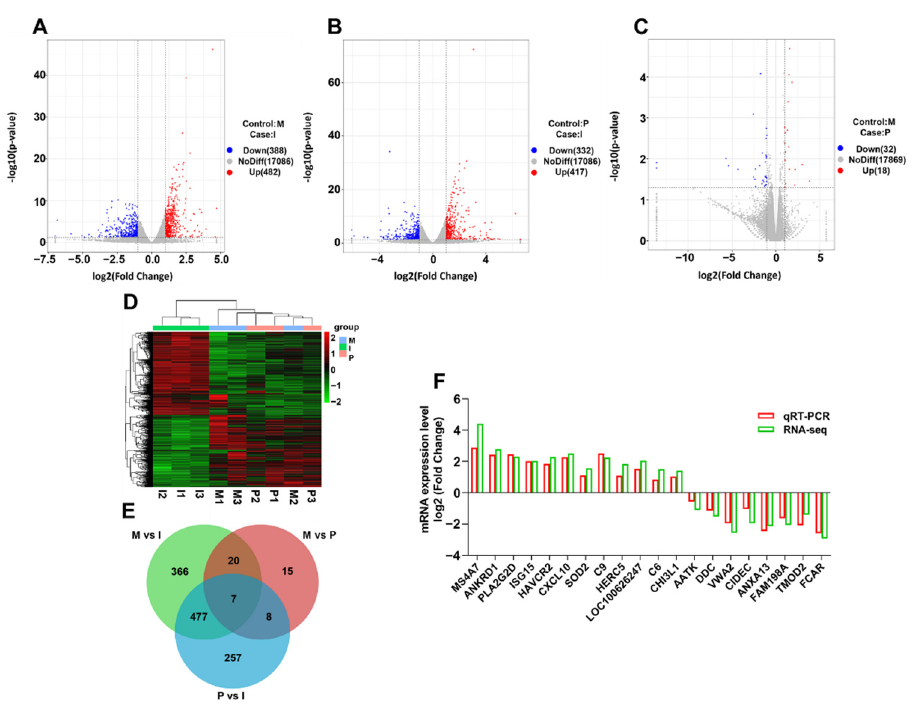
Figure 2. Transcriptome differences between the piglet lung tissue samples. Plot showing the log2 fold change and the − log10( p -value). The red points represented the up-regulated DEGs, and the green points represented the down-regulated DEGs (|log2 fold change| > 1), p -value < 0.05). ( A ) group P vs. group I; ( B ) group M vs. group I; ( C ): group M vs. group P; ( D ) Heat map of the DEGs in different groups; ( E ) using the Venn diagram for standard or unique DEGs; ( F ) qRT-PCR analysis of 20 DEG expression changes. The levels of β -actin normalized relative mRNA expression levels.